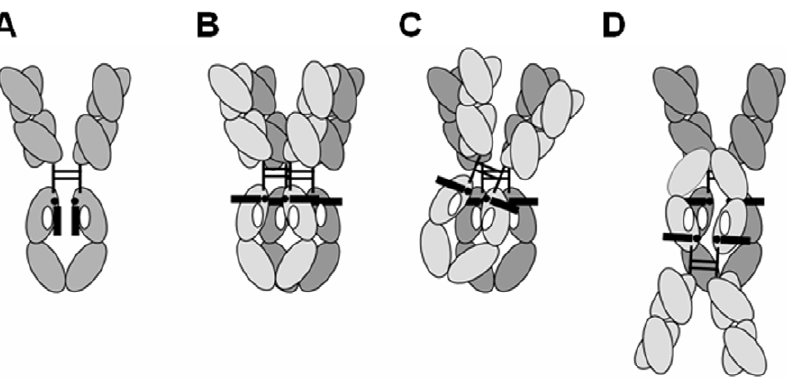
Figure 5. Model of an aggregation mechanism of IgG antibodies. (A) Native antibodies have carbohydrates that interact with neighboring amino acids on the inner side of C H 2. The light and heavy chains are presented in grey. The sugars are shown as a black bar, attached to Asn297, a black dot. White ovals represent a patch in C H 2 that is usually masked by the carbohydrates. (B–D) Dynamic motion of carbohydrates transiently exposes underlying protein hydrophobic residues. Stress, such as heat, exacerbates that motion, exposing aggregation-prone region, and resulting in protein aggregation where new glycoprotein interactions are formed. One antibody molecule is in light grey, and the other in dark grey. (B) Parallel stacking of full antibodies resulting from interactions between newly exposed protein patches. (C) Angled stacking for improved interaction between exposed protein patches. (D) anti-parallel stacking of full antibodies with interactions between newly exposed protein patches.